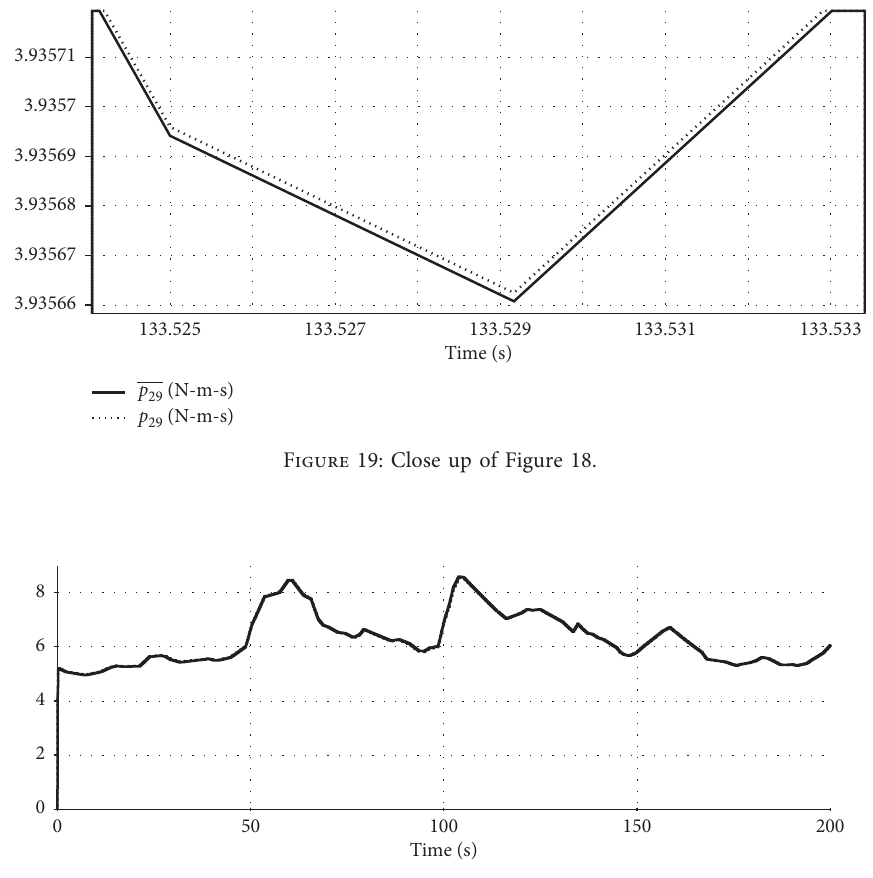
Figure 20: Full-time simulation of the slow variable p